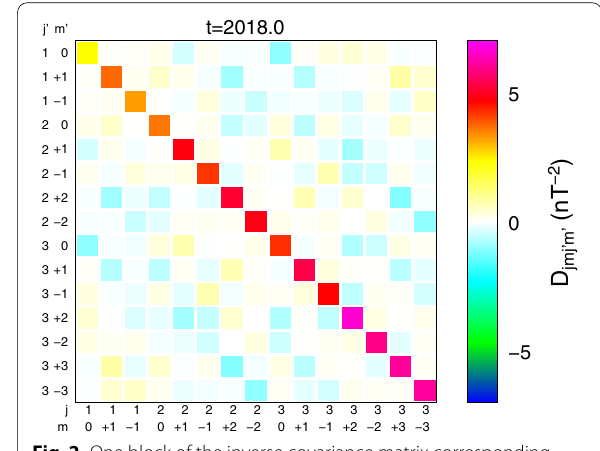
Table 1 Overview of various datasets for which the 3-D conductivity inversion is attempted